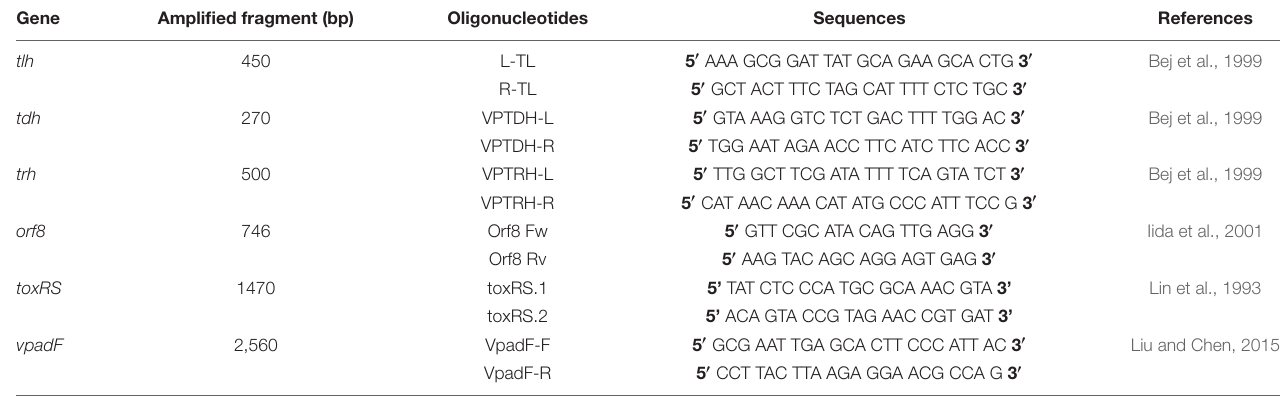
TABLE 2 | Oligonucleotide primers used in this study. Gene Amplified fragment (bp)